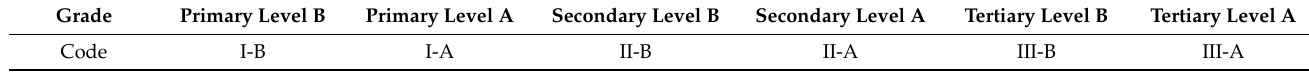
Table 3. Grades classification of qualified hospitals in China.